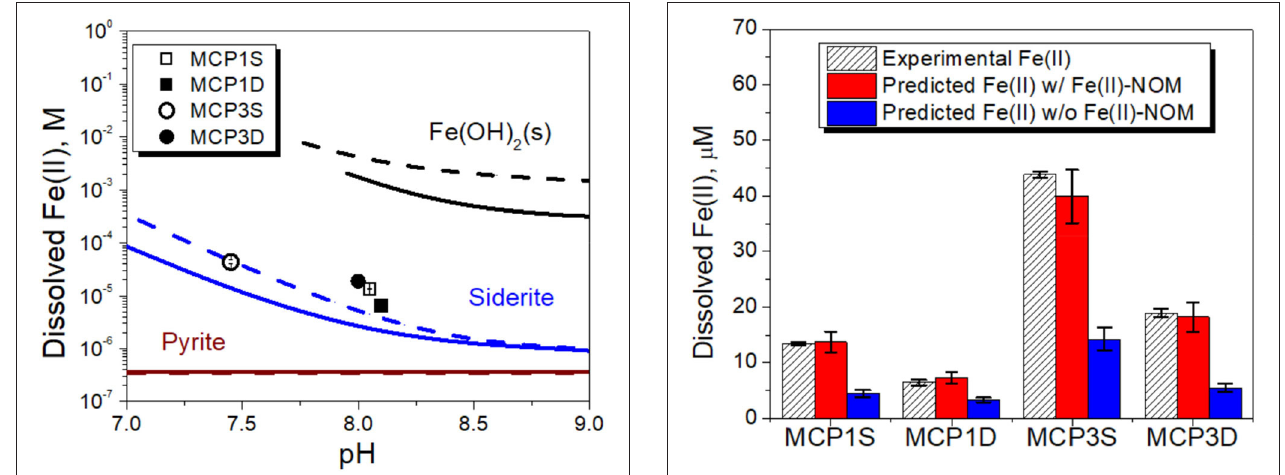
FIGURE 7 | Dissolved Fe(II) concentrations vs. predicted siderite solubility with and without including Fe(II)-NOM complexes. The error bars represent one standard deviation from duplicate